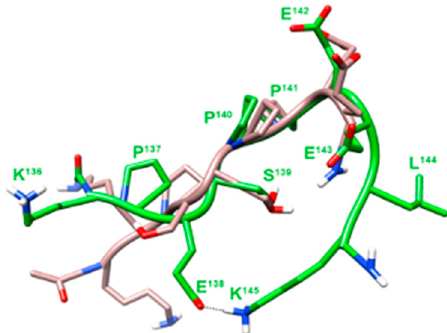
Figure 1. Superposition of the lowest energy conformer of uPA-(135–143) and Pep 1. Structures of uPA-(135–143) (grey) and Pep 1 (green) were superimposed using the backbone heavy atoms. Heavy atoms are shown with different colors (carbon, grey or green; nitrogen, blue; oxygen, red; hydrogen, white). For the sake of clarity, not all hydrogen atoms are depicted. Heavy backbone atoms are shown in ribbon format.